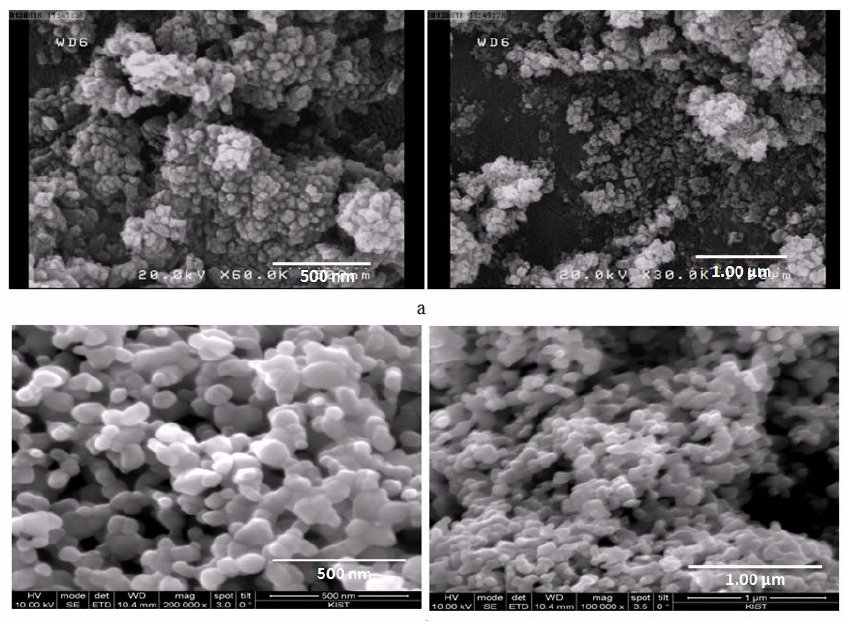
Fig. 3. SEM images of a) TiO